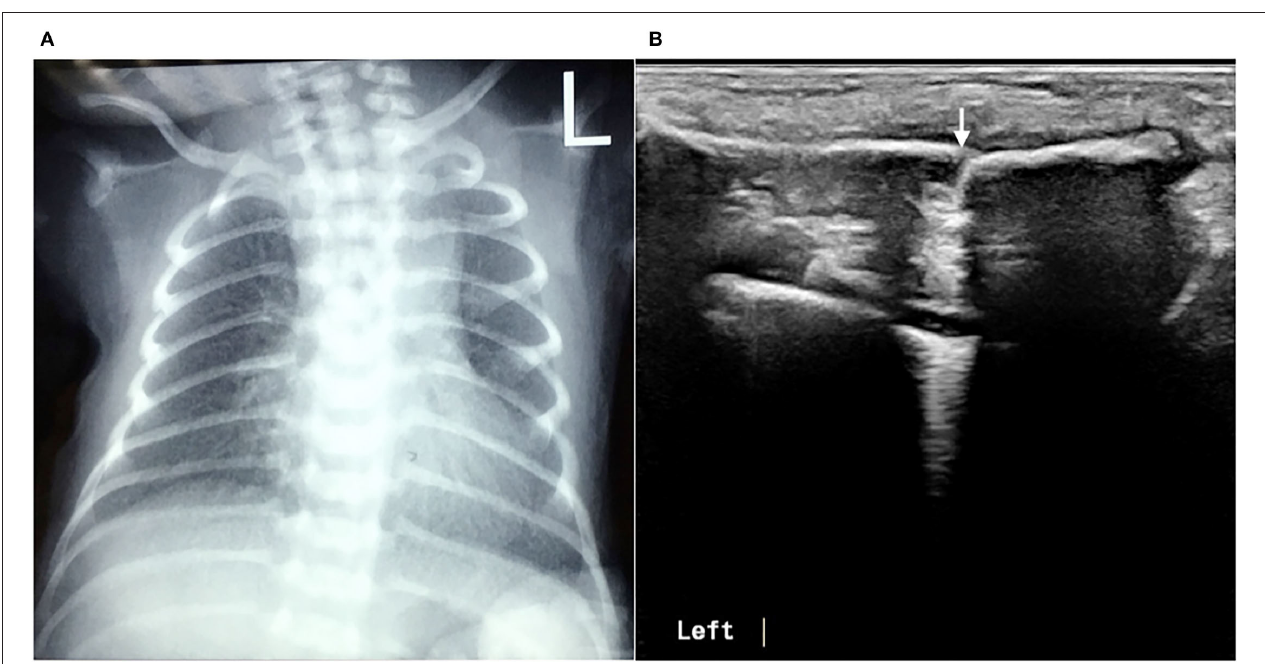
FIGURE 7 | Callus formation. The infant was G 1 P 1 , with a gestational age of 39 + 5 weeks, vaginal delivery, and a birth weight of 3,700g. The infant was admitted to the hospital on the 7th day after birth due to jaundice. Physical examination revealed local swelling and callus formation on the medial segment of the right clavicle. Ultrasound examination showed interrupted continuity and local bone tissue proliferation forming a callus at this fracture site (within the dashed line).